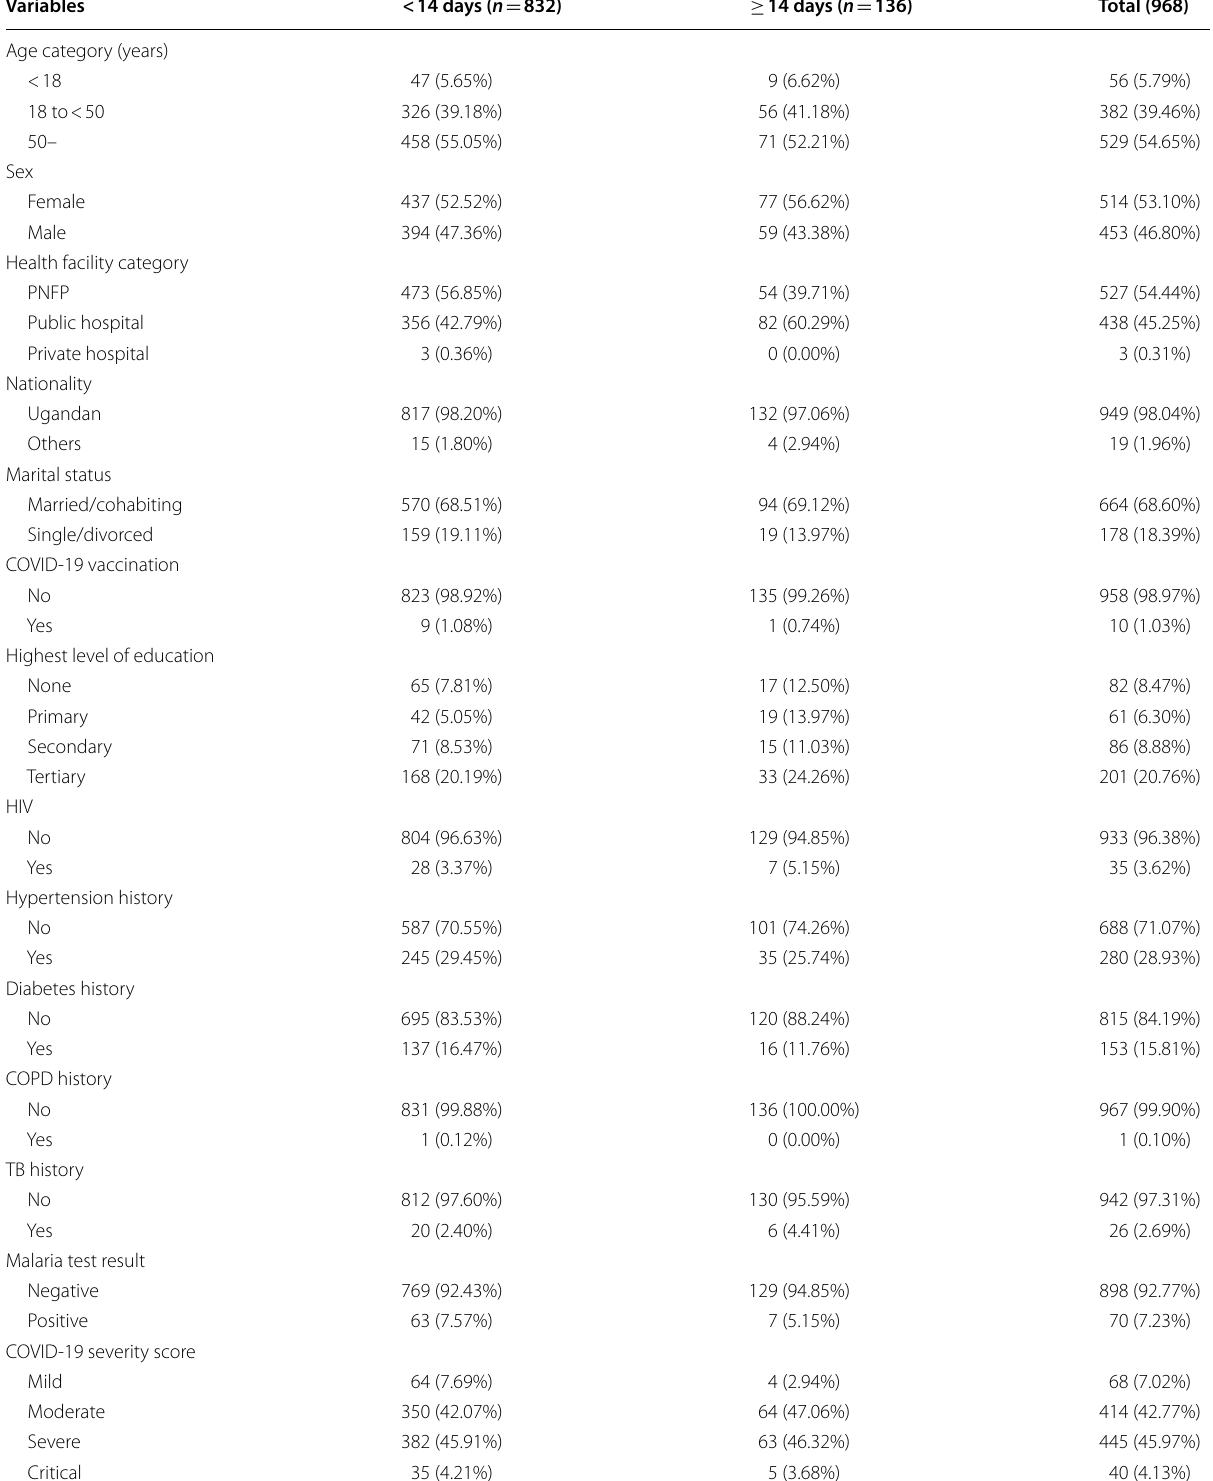
Table 1 Socio-demographic characteristics of patients with COVID-19 in Uganda